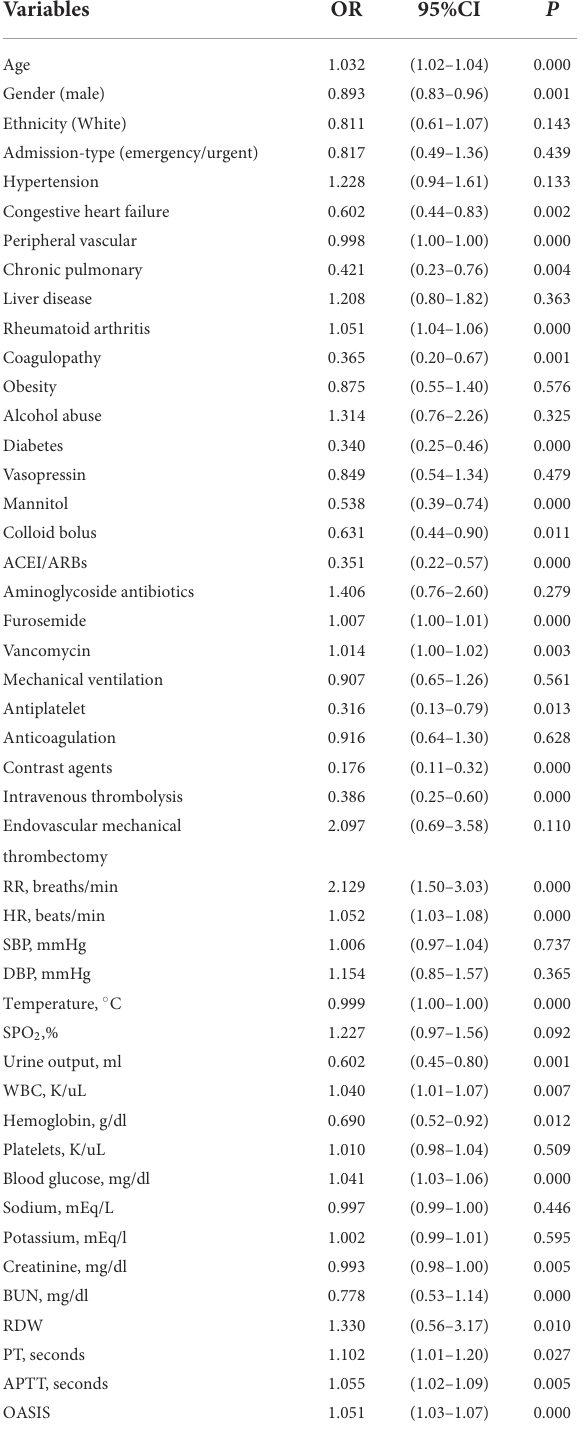
TABLE 3 Univariate logistic regression analysis of predictive variables of acute kidney injury (AKI) in the training cohort. Variables